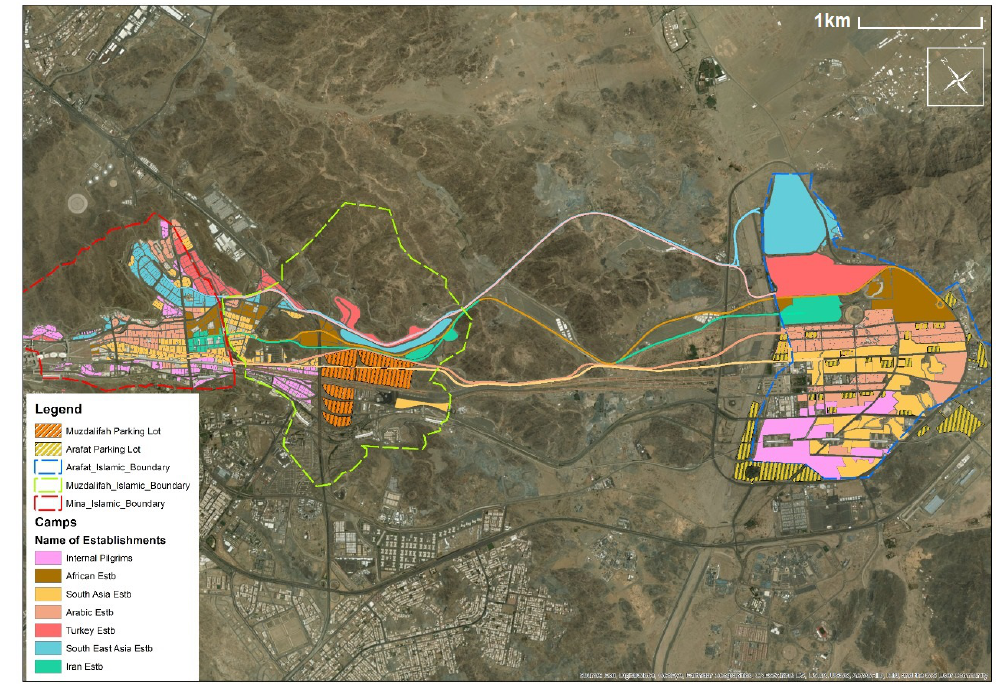
Figure 1. Map-based distribution of Establishments in Mashaer area (Mina, Muzdalifah and Arafat), their assigned